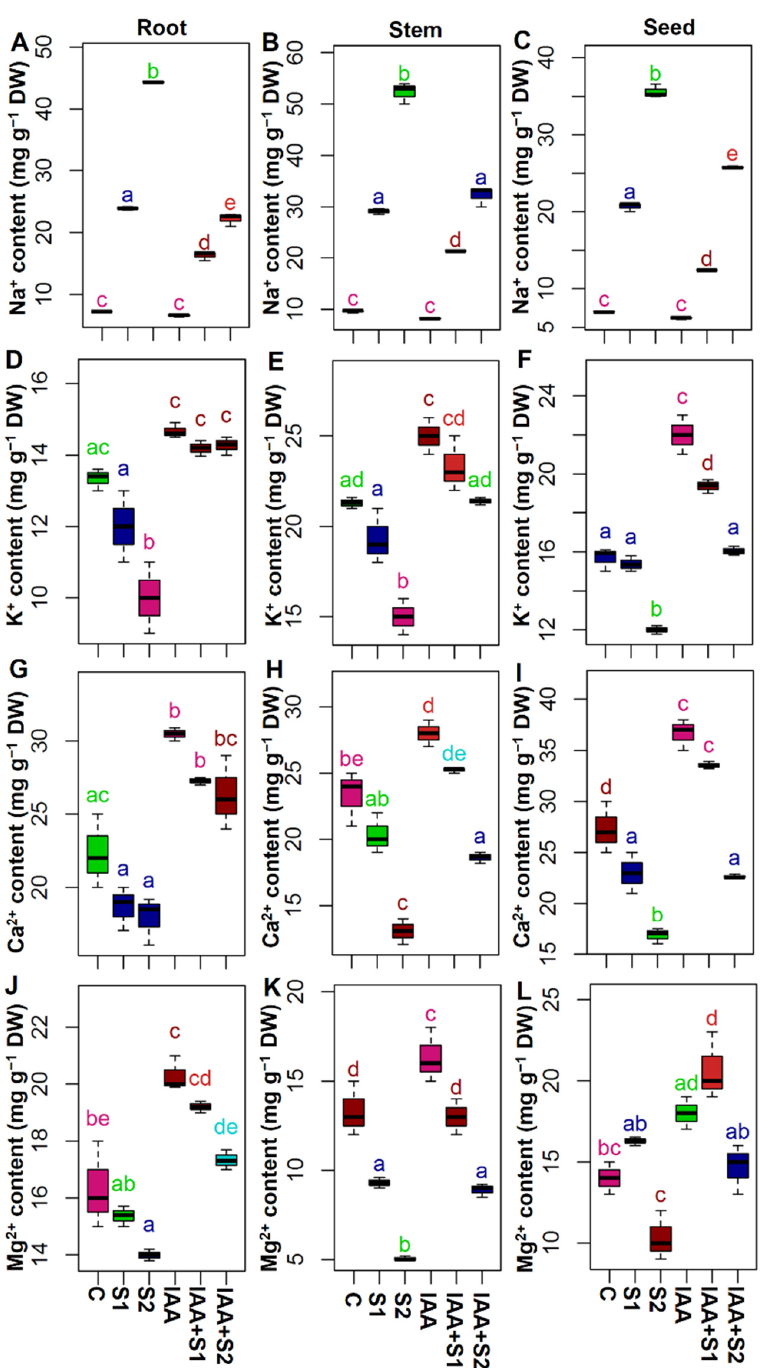
Figure 3. Effects of exogenous IAA on various mineral contents in root, stem and seed, including ( A – C ) Na + , ( D – F ) K + , ( G – I ) Ca 2+ , and ( J – L ) Mg 2+ contents of V. faba plants grown under non-stress and saline conditions. Each boxplot represents values of three independent replicates ( n = 3). Different letters above the bars indicate a statistically significant difference ( p < 0.05) by Tukey’s test. C, (control) 0 mM NaCl + water spray; S1, 60 mM NaCl + water spray; S2, 150 mM NaCl + water spray; IAA, 0 mM NaCl + 200 ppm IAA; IAA + S1, 60 mM NaCl + 200 ppm IAA; IAA + S2, 150 mM NaCl + 200 ppm IAA.